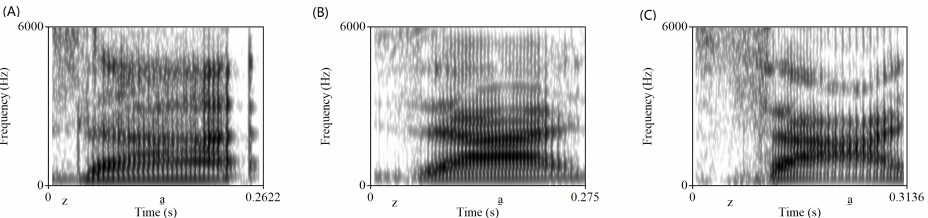
Figure 1. Three types of creakiness: ( A ) Coda glottal stop: short silence followed by a strong glottal pulse at the end of the syllable. ( B ) Coda creak: irregular voicing towards the end of the syllable. ( C ) Broader creak: irregular voicing occurred earlier than the last third of the vowel